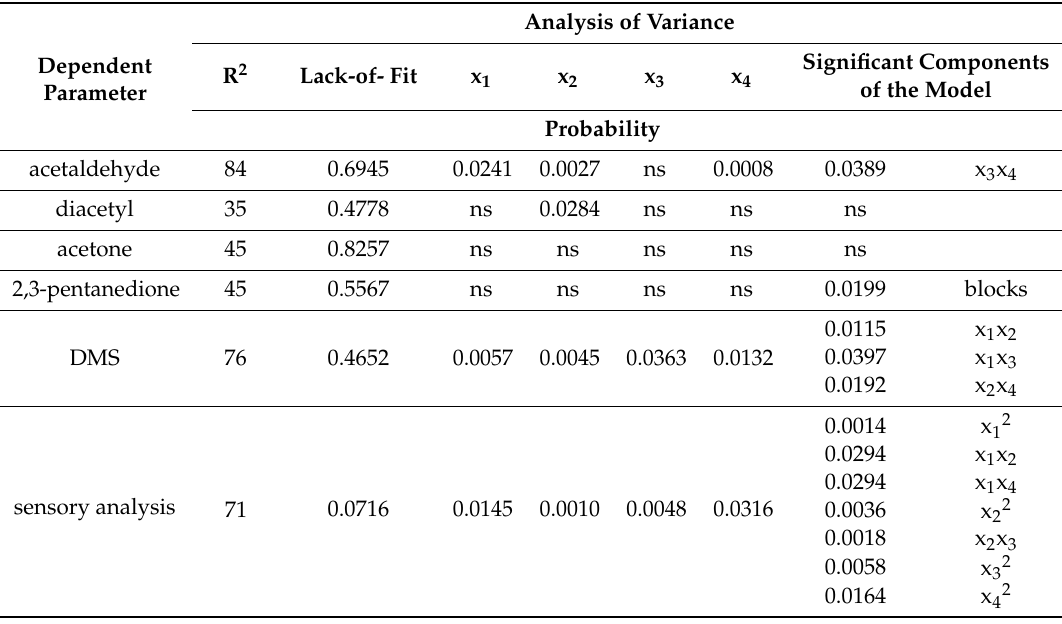
Table 2. Analysis of variance of the selected volatile components and sensory analysis: significance of model components and assessment of adequacy of the